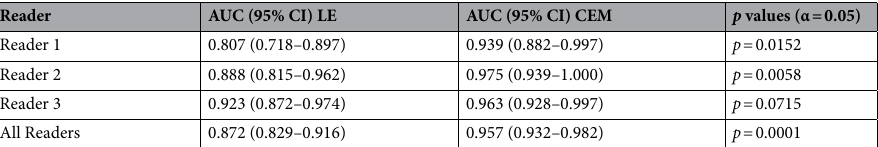
Table 4. AUC values and corresponding p values for both LE and CEM exams, per individual reader and for all readers combined. AUC Area under the curve, CI Confidence interval, LE Low-energy, CEM Contrast- enhanced mammography (CEM).